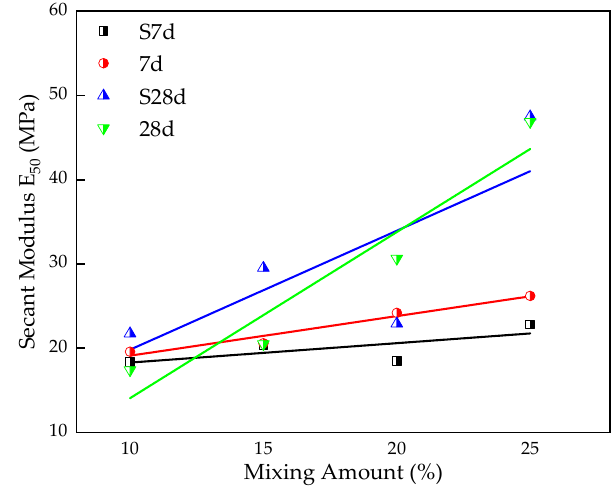
Figure 9. Effect of TS content on E50 of stabilized silt. Moreover, it has been speculated that there is a certain linear relationship between E 50 and UCS. Figure 10 is obtained by linear fitting of E 50 and UCS [6]. As shown in it, E 50 and UCS are strongly correlated when the curing age is 7d, S7d, and 28d, and the relationship of the fitted line is obtained as shown in Equations (3)–(5), where the correlation coefficient R 2 is 0.95, 0.91, and 0.95, respectively. However, the relationship for S28d samples is not obvious.